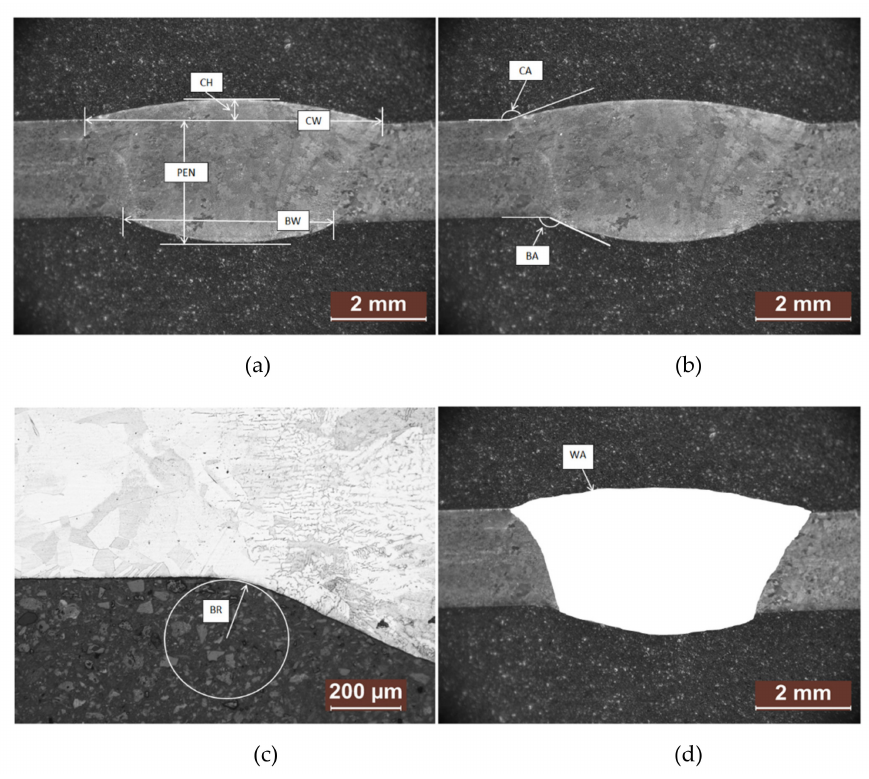
Figure 4. Geometrical measurements of the welds taken using a Leica DM2700 optical microscope ( a ) CH , CW , PEN and BW ; ( b ) CA and BA ; ( c ) BR ; ( d ) WA